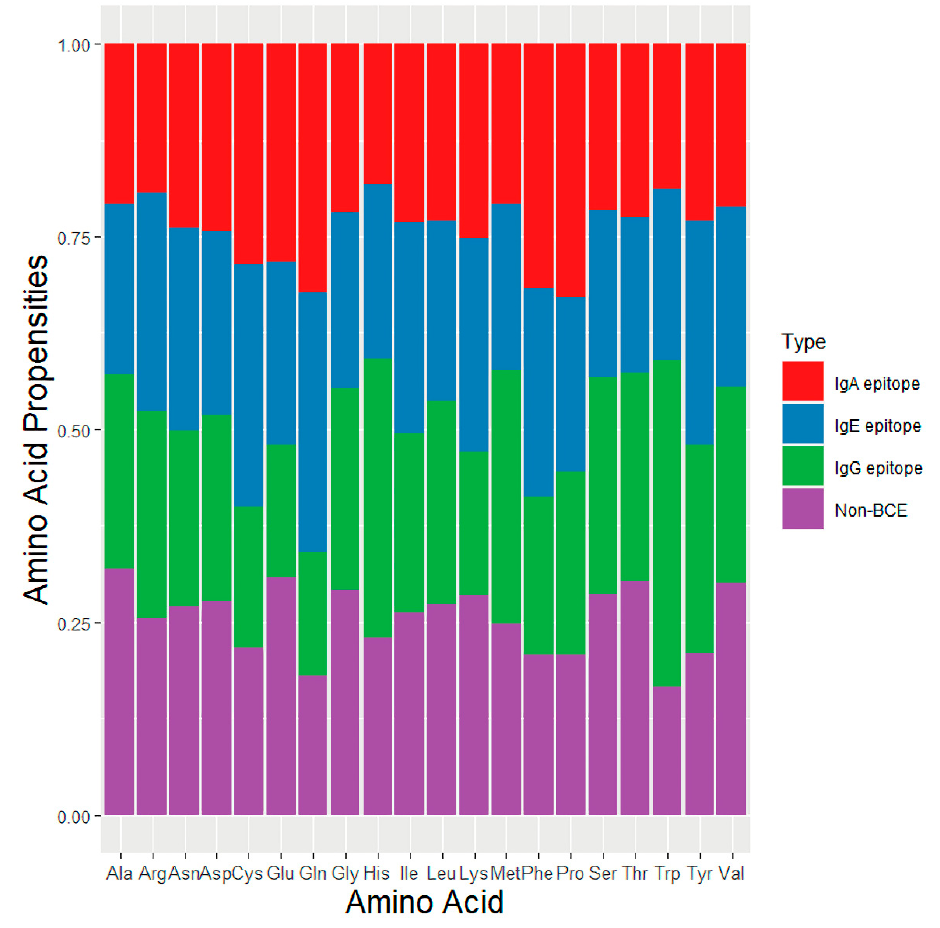
Figure 2. NIgPred data set of amino acid propensities.